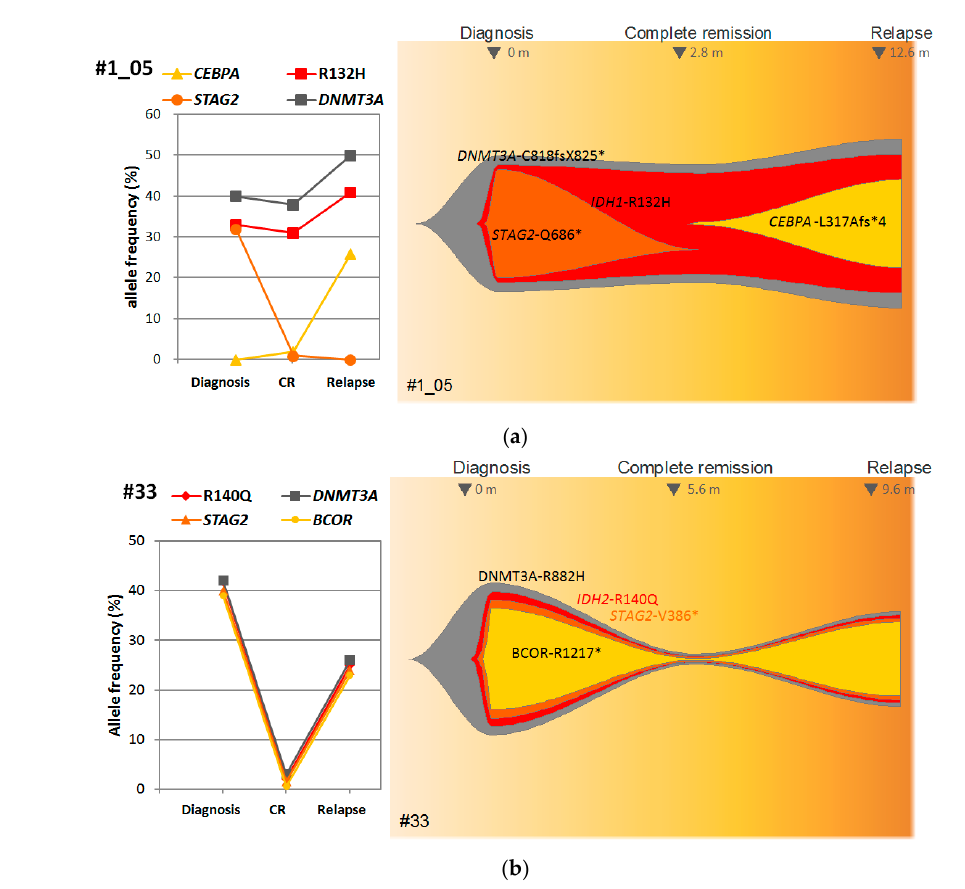
Figure 5. Changes in allele frequency of concurrent mutations ( left ) and hypothesized clonal evo- lution ( right ) at diagnosis, complete remission, and relapse of AML. ( a ) A patient with persistently high IDH1 -R132H MRD, and ( b ) a patient with concordant IDH2 -R140Q